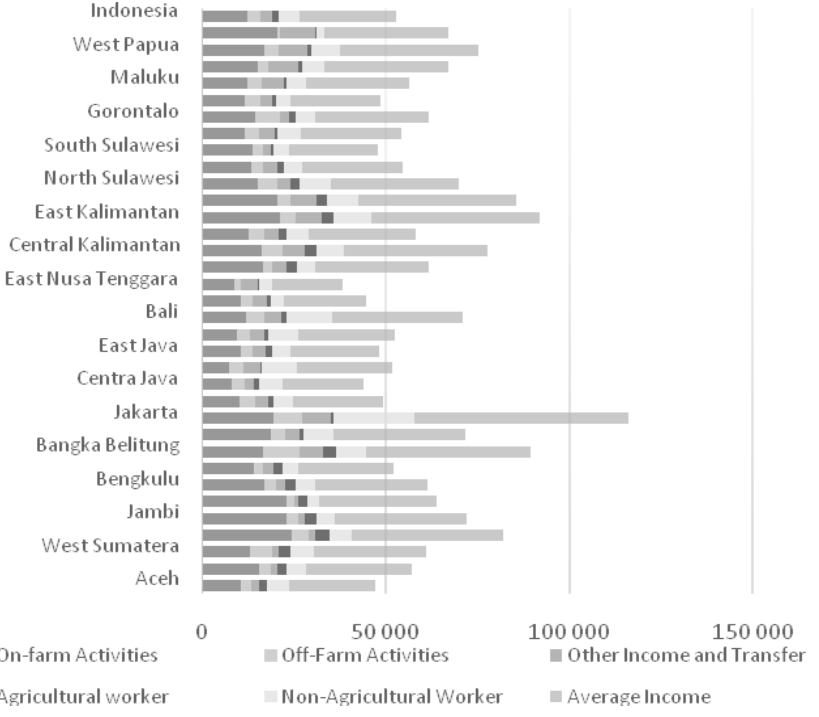
Figure 6: Average of Farm Household Income by Region and Source of Revenue Over the Past Year (000 IDR). Source: Indonesia Statistic Bureau, Sensus Pertanian